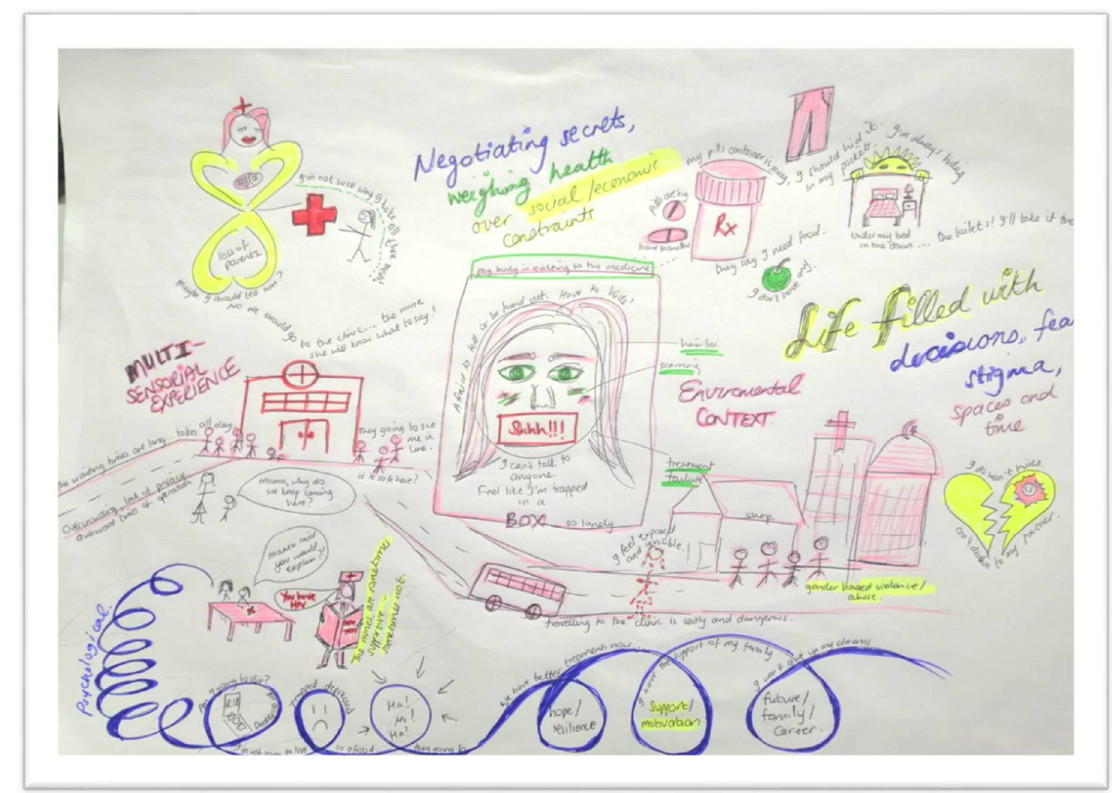
Figure 6. Storyboard of adherence to ART for YLPHIV.